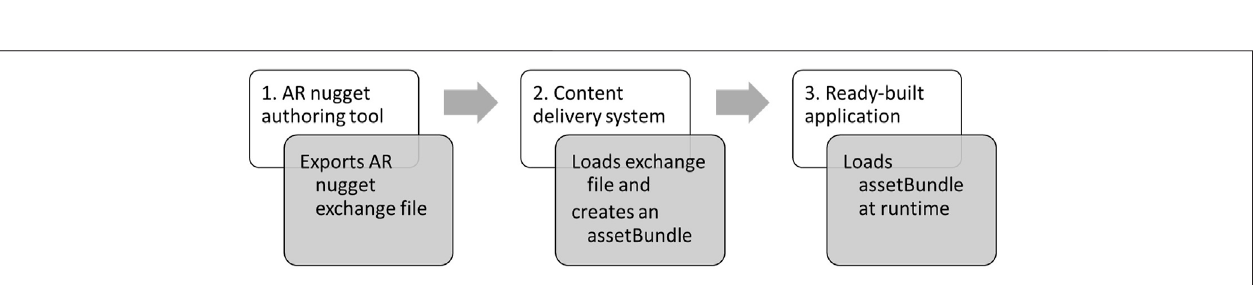
FIGURE 7 | Toolchain for on-demand AR content delivery to a ready-built